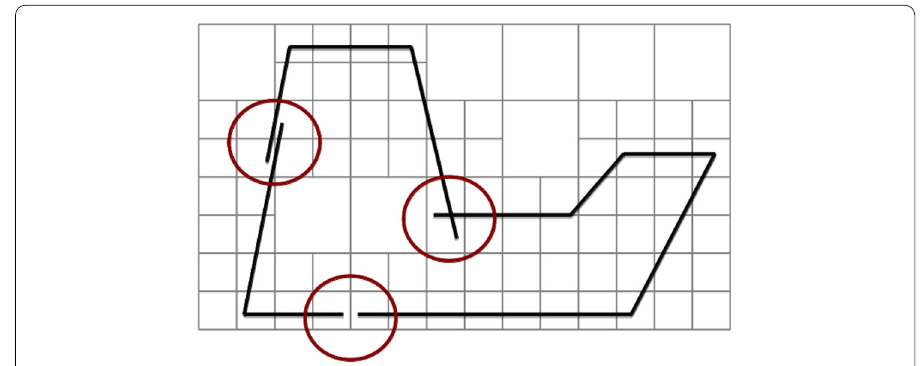
Fig. 29 A non-watertight geometry with gaps and overlaps